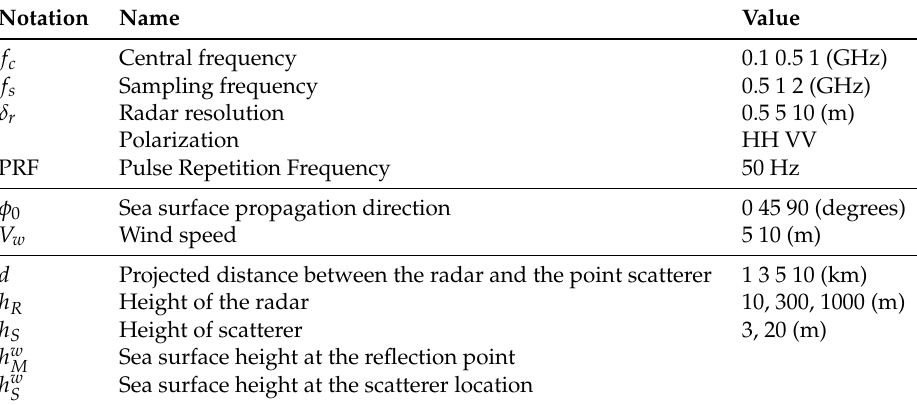
Table 1. Radar/ship/sea parameters used in 2-D profile